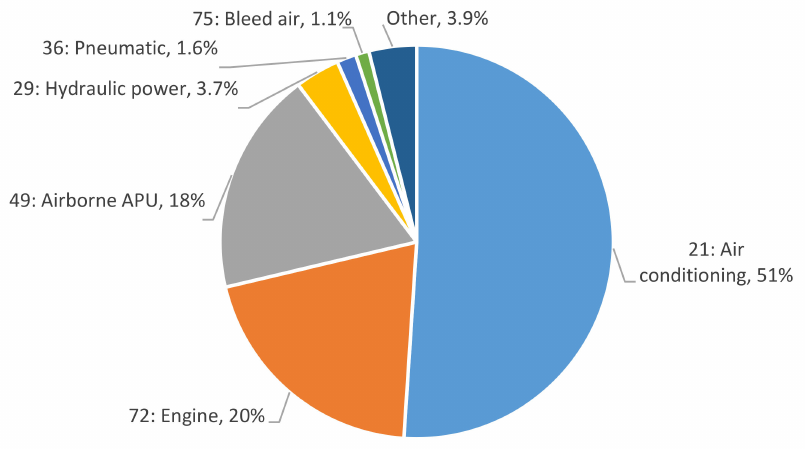
Figure 4. ATA chapters assigned by airlines to 3360 fume events (oil, hydraulic,